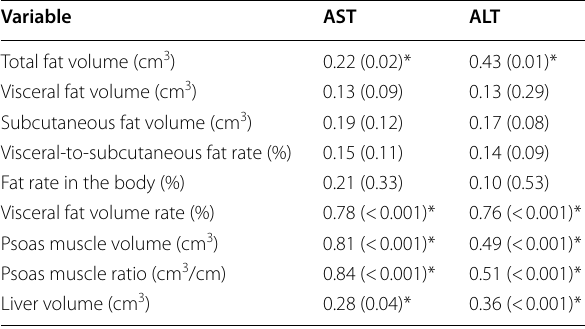
Table 6 Visceral, subcutaneous fat, liver volume, psoas